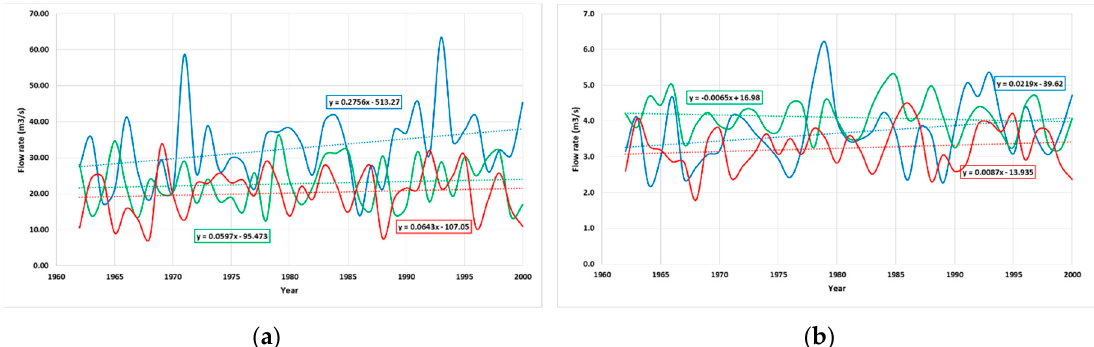
Figure 10. Daily flow rate evolution during control period (1961–2000) for real data (blue), BCC (green)